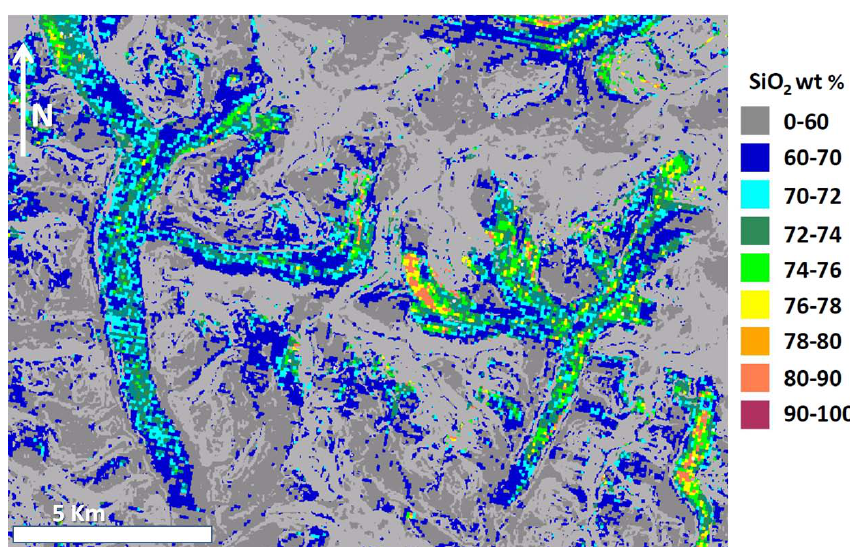
Fig. 6. Debris covered glacier areas are evident by elevated silica content in this ASTER thermal emissivity SiO 2 weight percent thematic